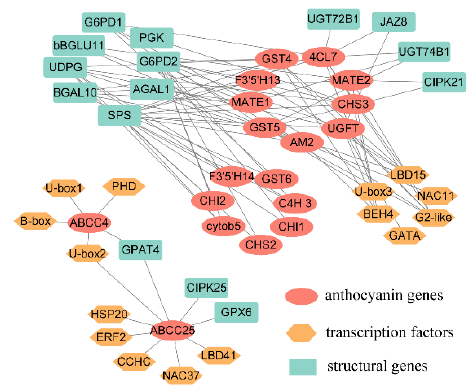
Figure 6. Integrated co-expression network of anthocyanin-related genes. The transcription factors in the network included two NAC transcription factors ( NAC11 and NAC37 ); two LOB domain–containing transcription factors ( LBD15 and LBD41 ); an ethylene response factor ( ERF2 ); zinc finger ( CHY-type , B-box , CCHC , PHD , and GATA ) and protein phosphatase 2C ( PP2C ); G2-like ; three U-box transcription factors ( U-box1-3 ) and a heat shock protein ( HSP20 ); and a BES1/BZR1 homolog transcription fac ‐